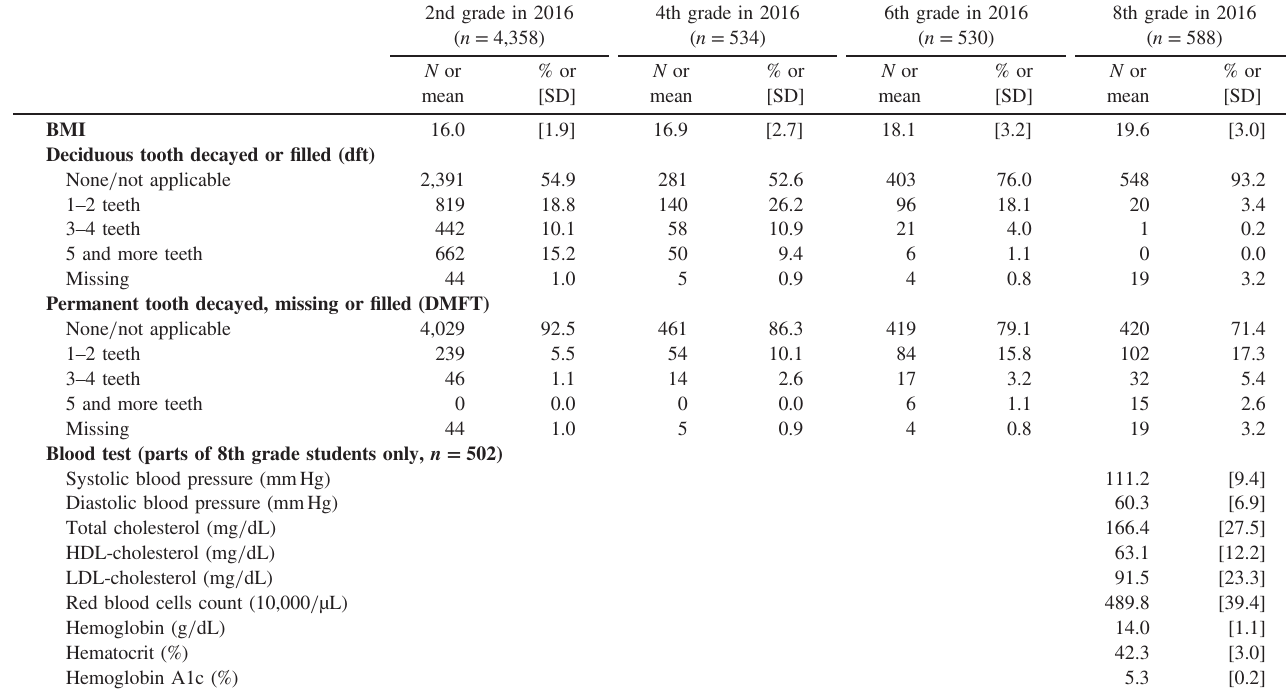
Table 8. Selected pro fi les of the school health checkup in the second survey of A-CHILD survey in 2016